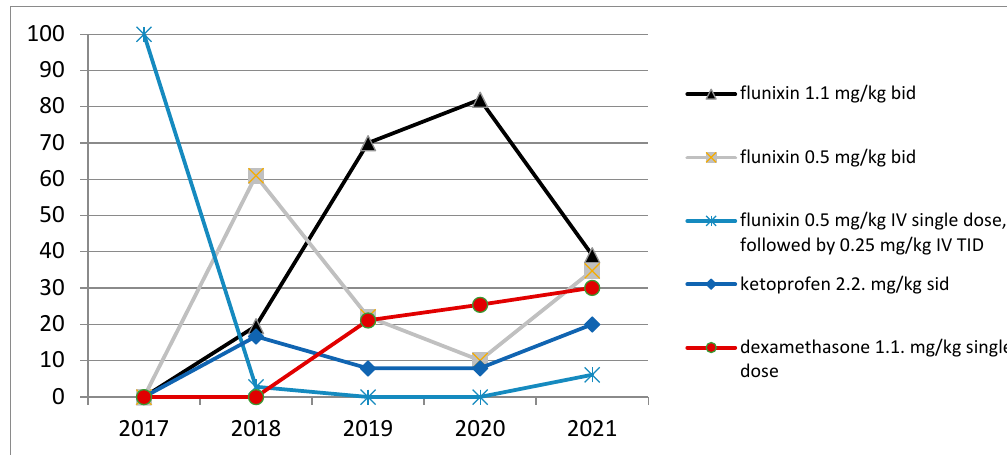
Figure 3. Use of anti-inflammatory drugs during the years in our referring center.